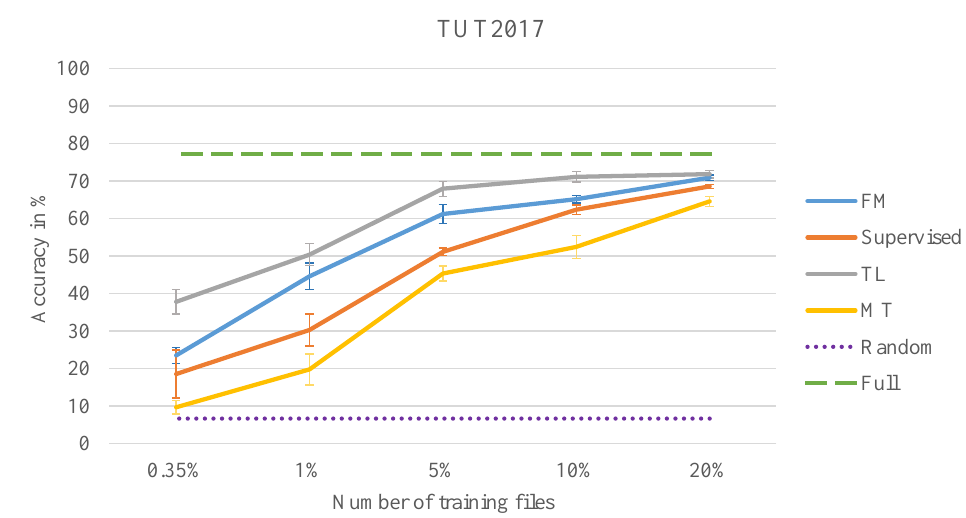
Figure 5. Mean accuracy and standard deviation for FixMatch (FM), fully supervised training (Supervised), Transfer Learning (TL), and Mean Teacher (MT) on TUT2017 test set. Additionally, the supervised baseline using the full training set (Full) and the random baseline are shown.